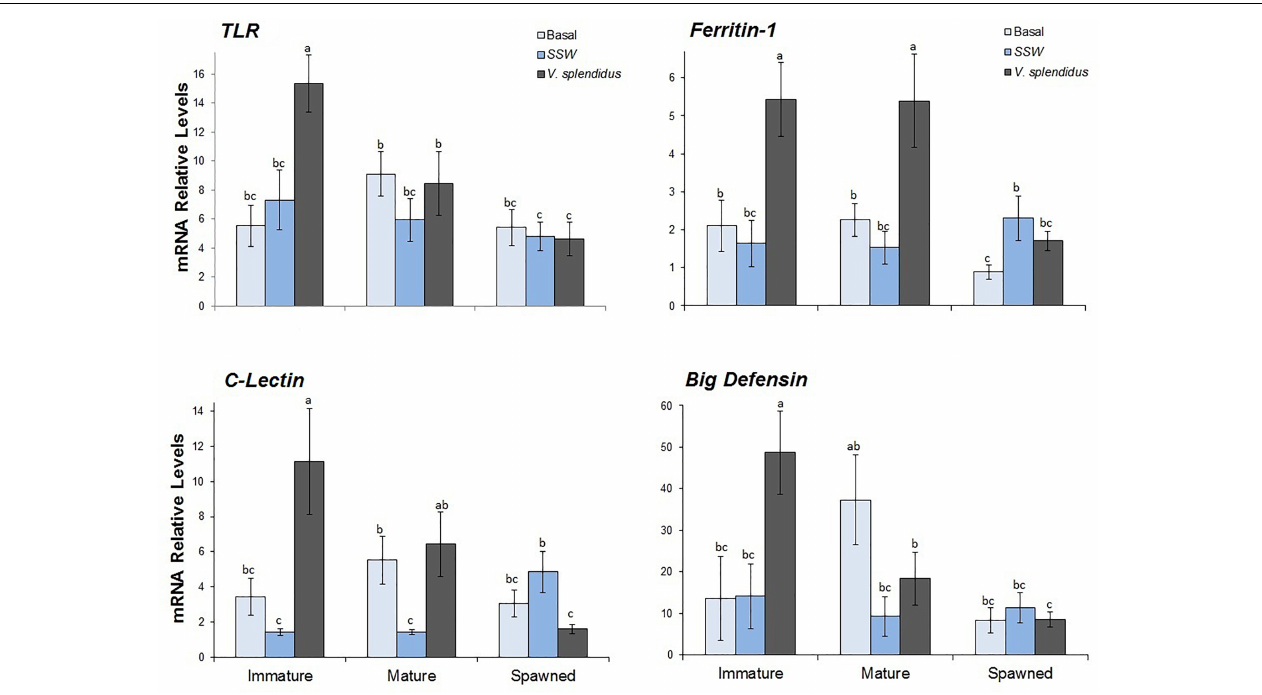
FIGURE 7 | Effects of in vivo challenge with V. splendidus on transcriptional levels of immune-related genes in hemocytes from immature, mature, and spawned A. purpuratus . Values associated with the same letter belong to the same subset based on a FDR-BY (false discovery rate) post hoc test (Benjamini and Yekutieli, 2001) ( n = 4–8 per condition and